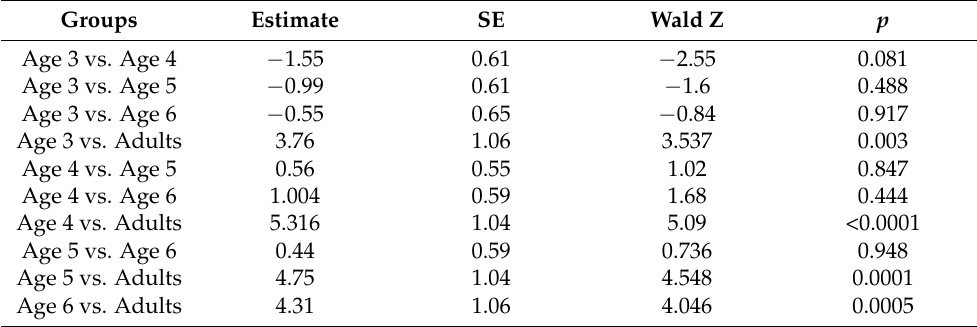
Table 7. Summary of the age factor in the mixed effects logistic regression model for producing SEMANTICALLY INAPPROPRIATE RC S